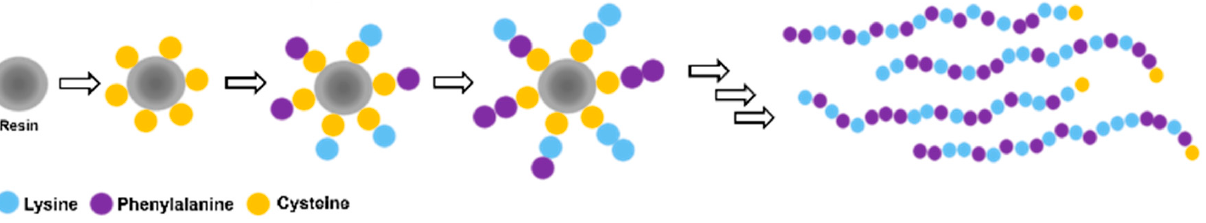
Figure 1. Solid-phase peptide synthesis of phenylalanine–lysine random peptide mixtures with cysteine at the C’ terminus (first coupling step: yellow circle). After the first coupling of cysteine, a 1:1 mixture of Fmoc–phenylalanine and Fmoc–lysine-(Boc) was coupled at each of the following 20 coupling steps to generate a 21-mer of Cys-[(Phe) 0.4 -(Lys) 0.6 ] n = 20 , abbreviated as CFK.